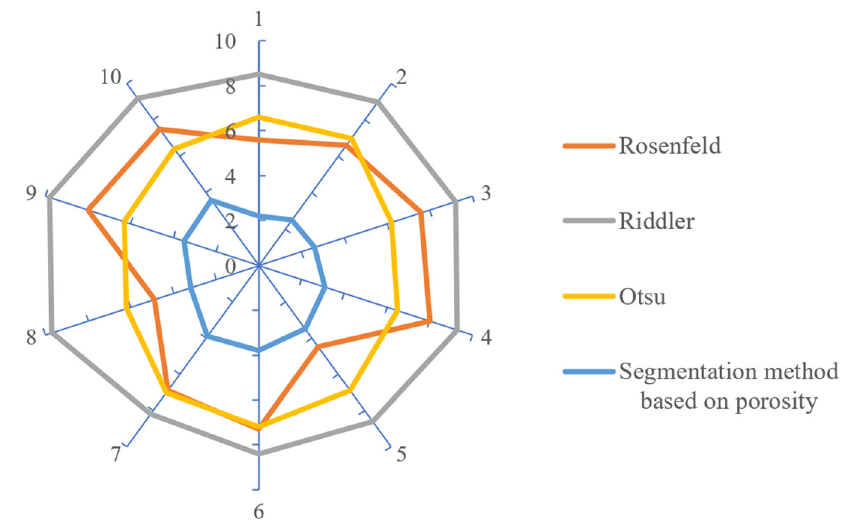
Figure 7. Selection of image segmentation method.